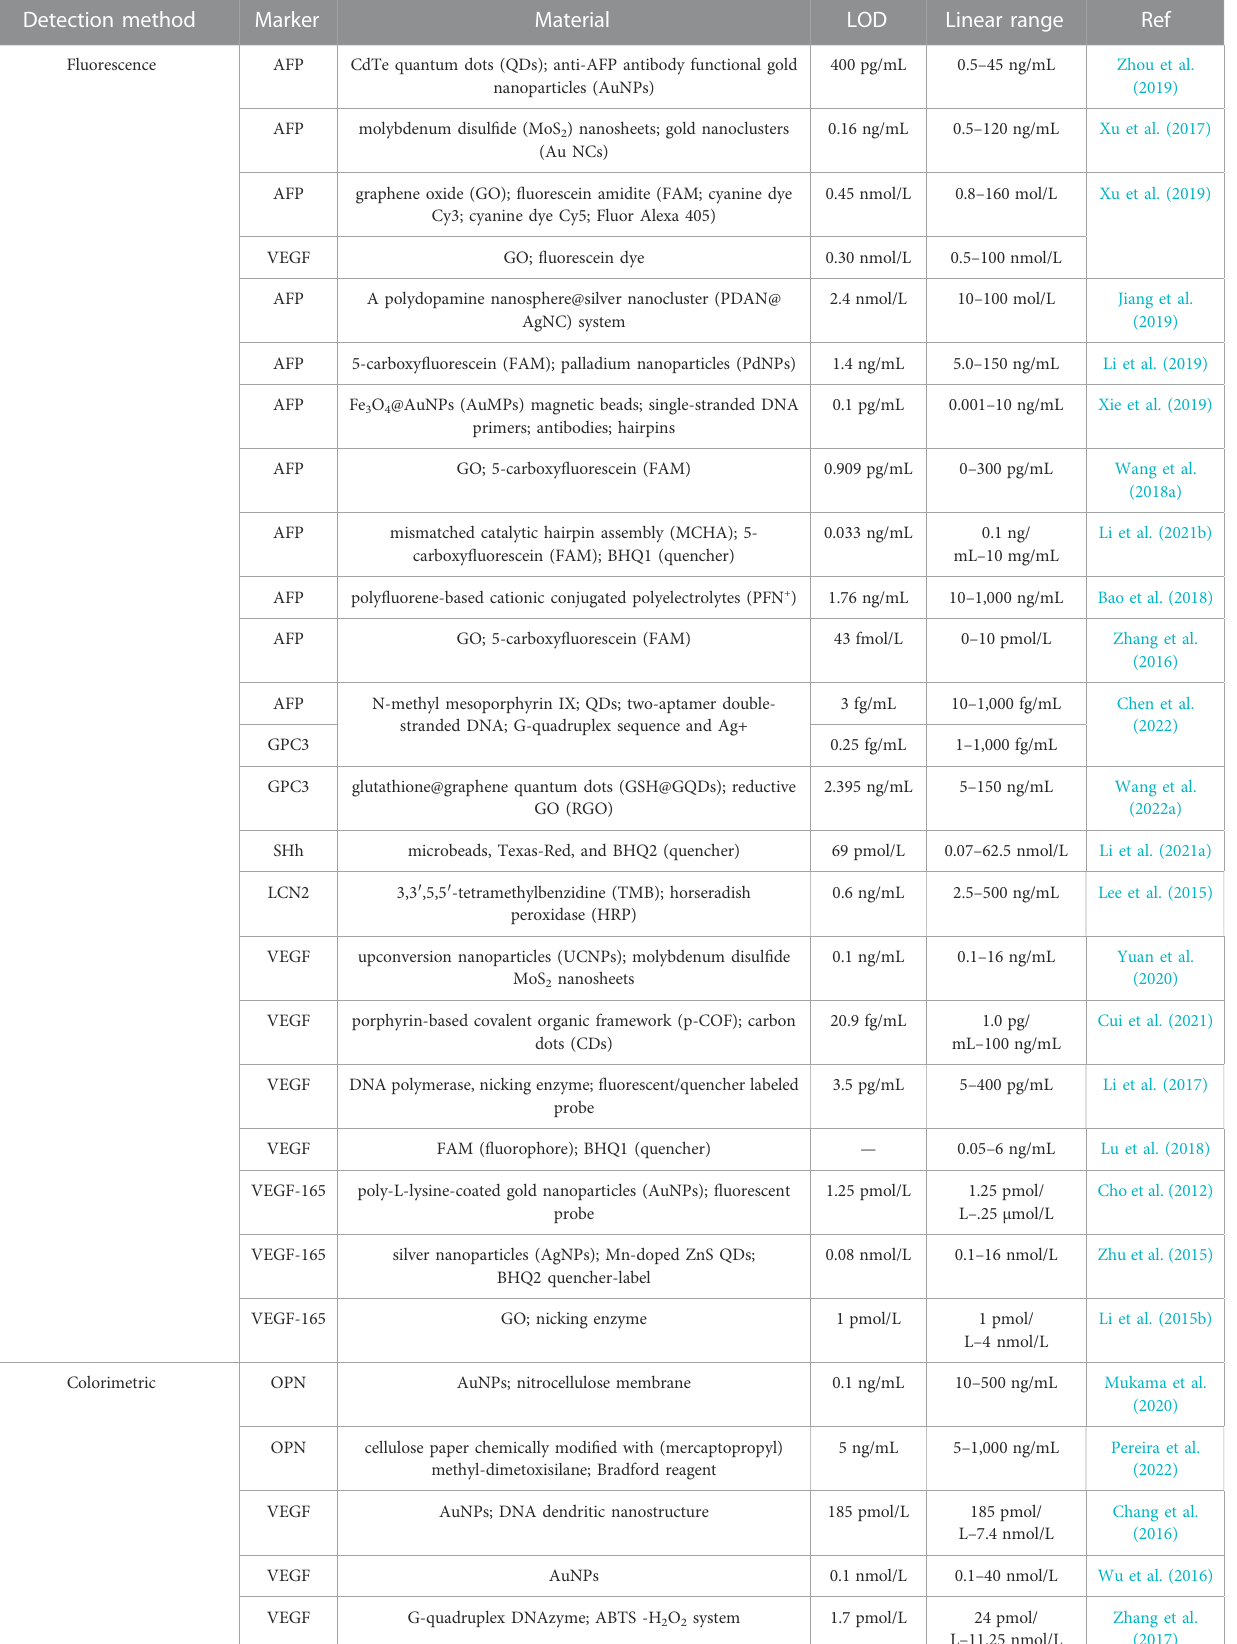
TABLE 2 | Summary of biomarkers related to hepatocellular carcinoma (HCC) surveillance and diagnosis using optical